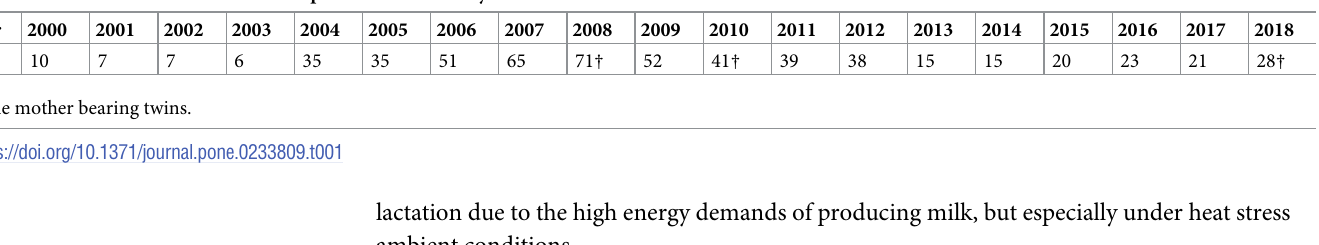
Table 1. Number of mother-calf red deer pairs across the